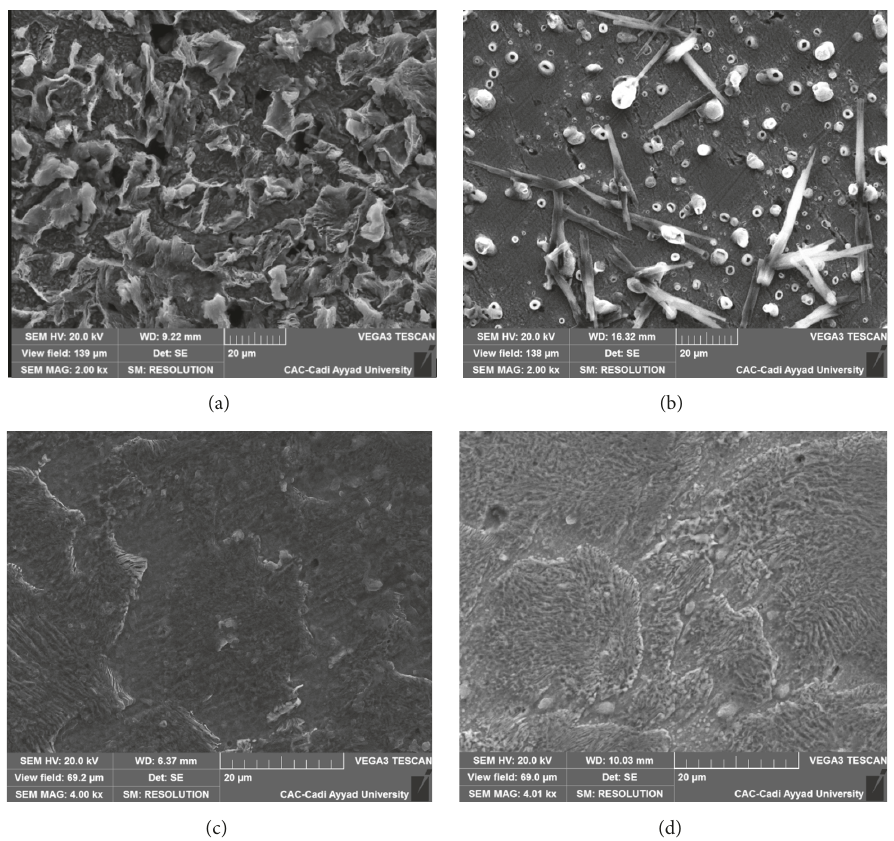
Figure 8: SEM images of steel in 1MHCl solution after 2 h of immersion at 293 K; (a) steel in 1MHCl (Blank), (b) steel in 1MHCl in the presence of inhibitor (5) , (c) steel in 1MHCl in the presence of inhibitor (6) , and (d) steel in 1MHCl in the presence of inhibitor (7) .